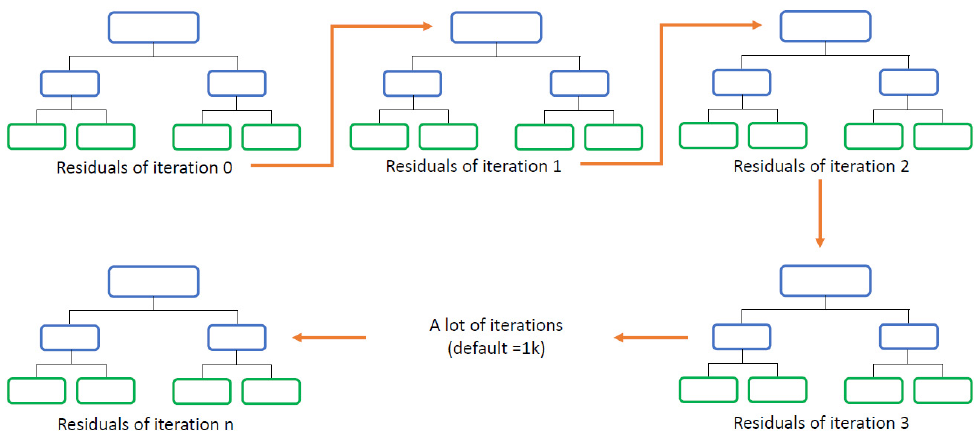
Figure 3. Series of decision